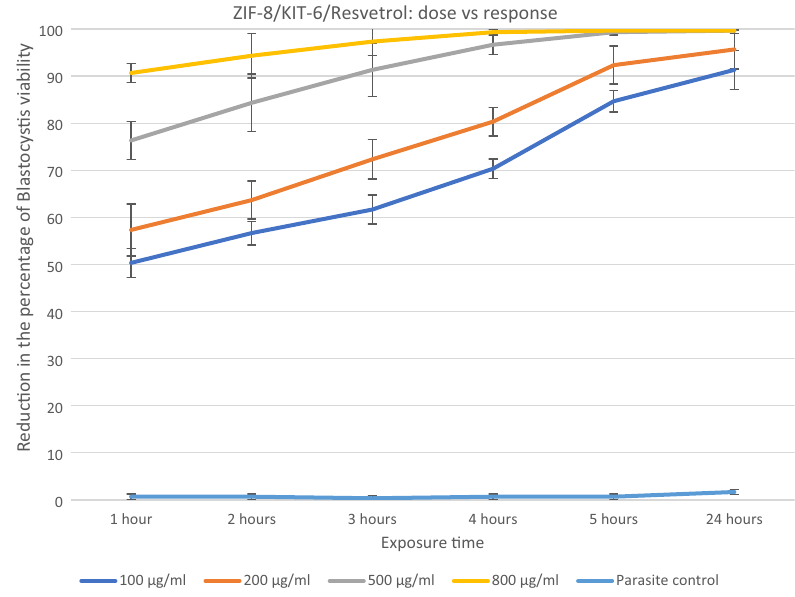
Figure 6. Reduction in the percentage of blastocystosis cysts viability after exposure to increasing concentrations of ZIF-8/Kit-6/Resveratrol nanocomposite.